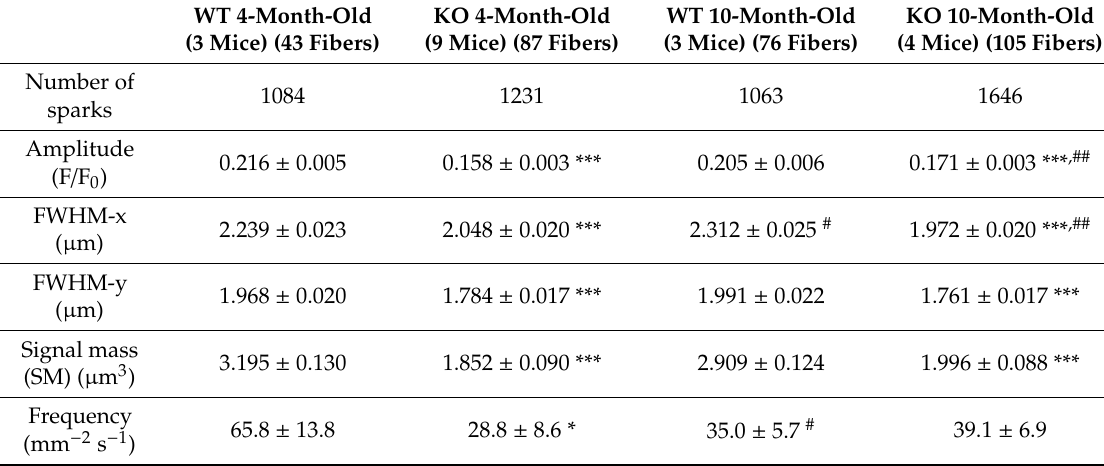
Table 2. Parameters of CREs in WT and sAnk1 KO fibers.